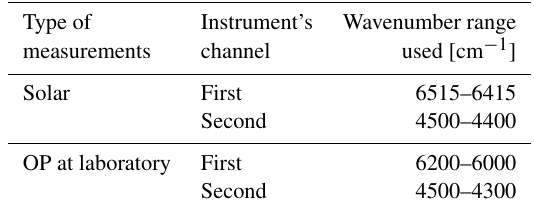
Table 4. Description of the wavenumber region utilized for each channel and for each kind of